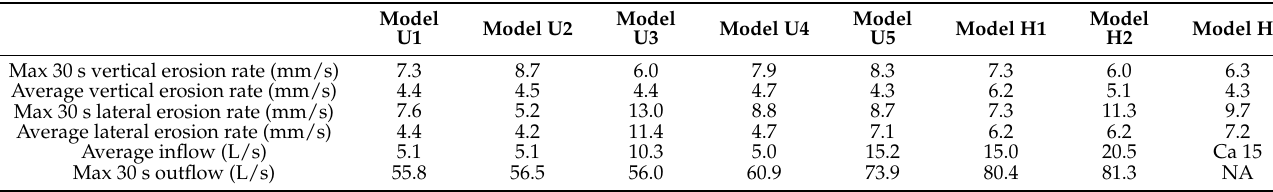
Table 3. Summary of results on erosion